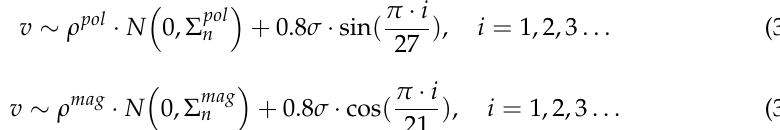
random quantity.